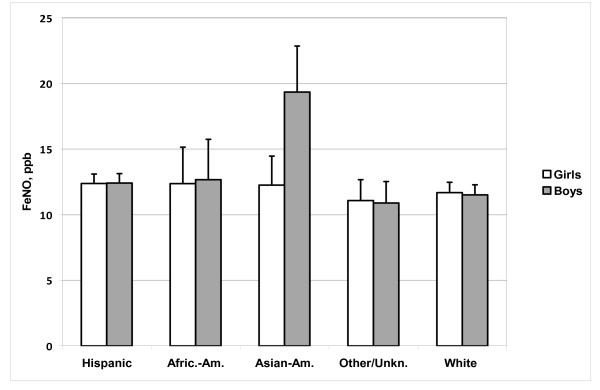
Estimated online FeNO by sex and ethnic group, adjusted for clinical status, age, body size, and community effects. Bar indicates geometric mean, flag indicates upper 95% confidence limit of geometric mean. See Table 1 for number of subjects in each group. Significant differences: Hispanic > white, P = 0.02; Asian > white, P < 0.0001; Asian boys > Asian girls, P < 0.0001.